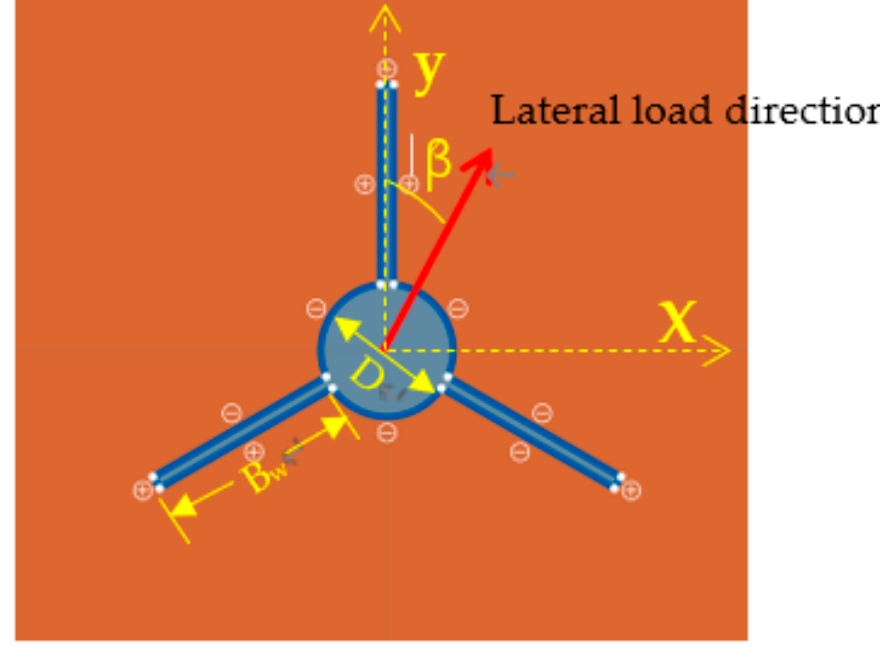
Figure 2. Calculated section of three-wing pile.